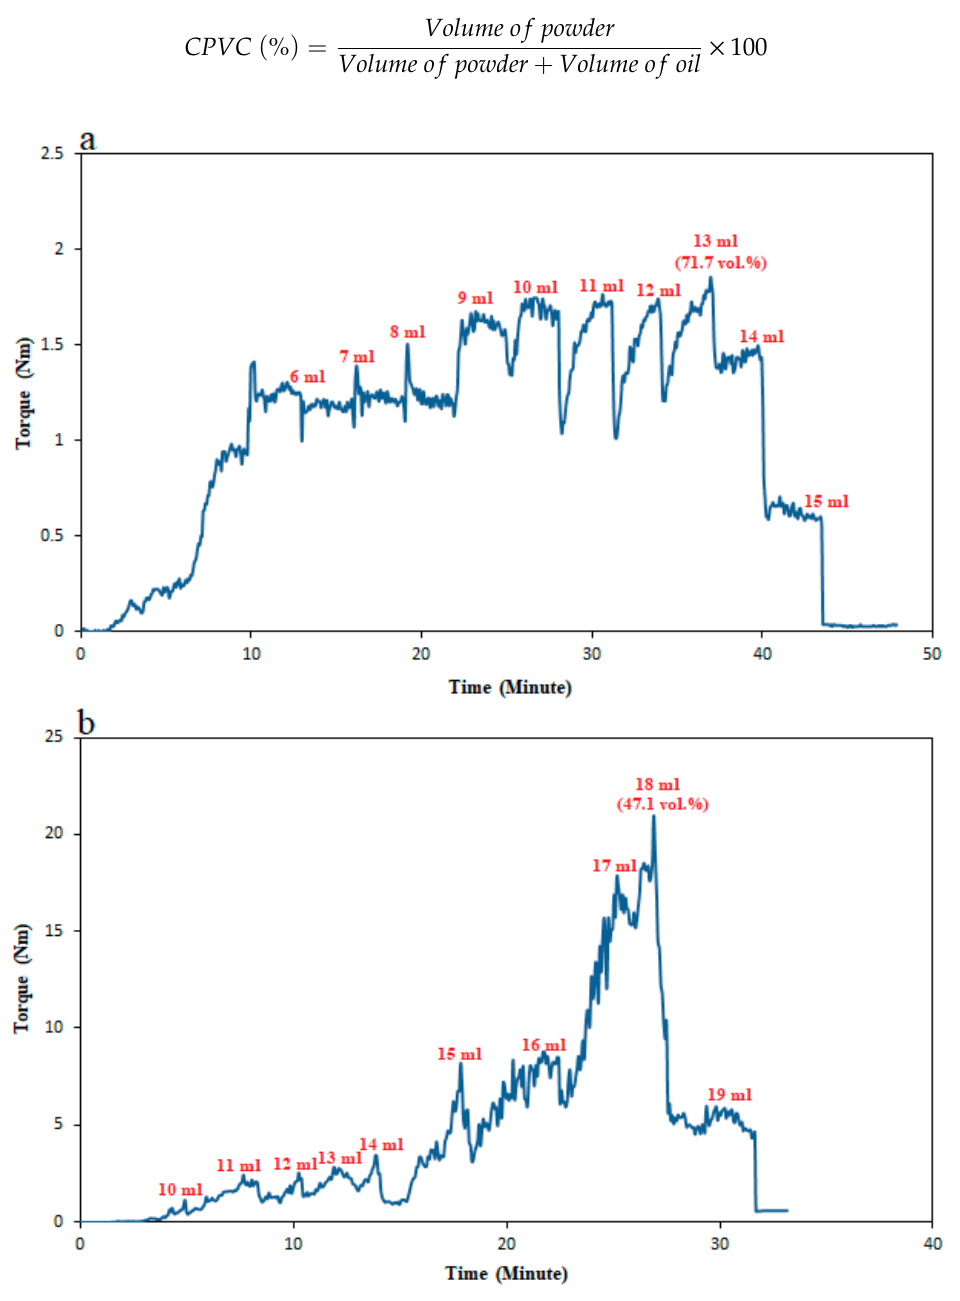
Figure 4. Evaluation of torque as a function of time for the powders ( a ) SS 17-4PH; and ( b ) 3YSZ.